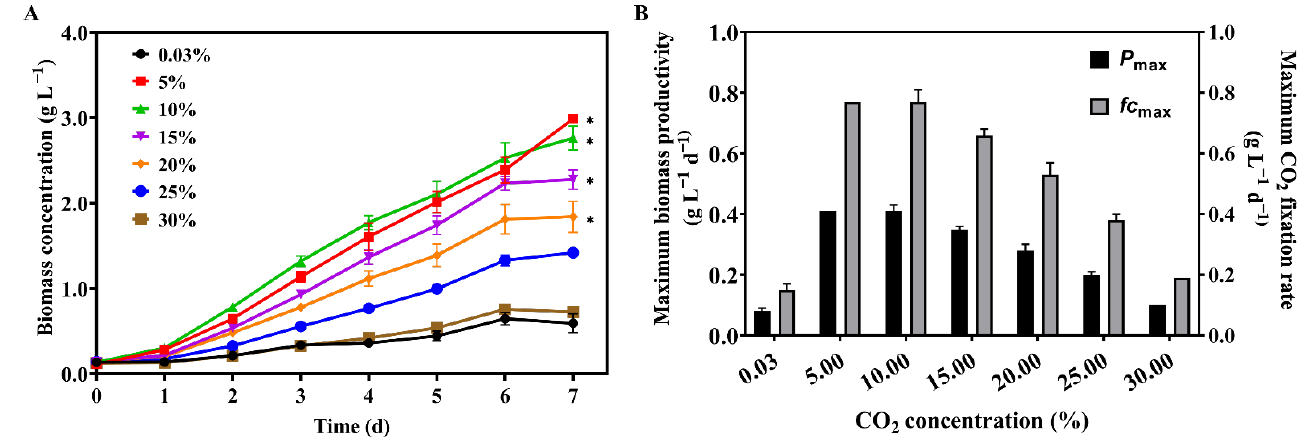
Figure 1. Growth ( A ) and the maximum biomass productivity ( P max) and maximum CO 2 fixation rate ( fc max) ( B ) of Scenedesmus sp. FSP3 under different CO 2 concentrations. Dunnett’s test was performed to determine statistically significant difference: *, p < 0.05, n = 3.